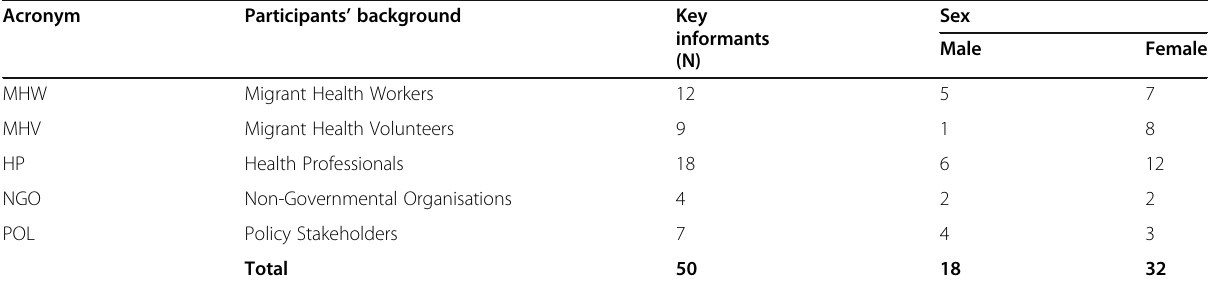
Table 1 Characteristics of key informants